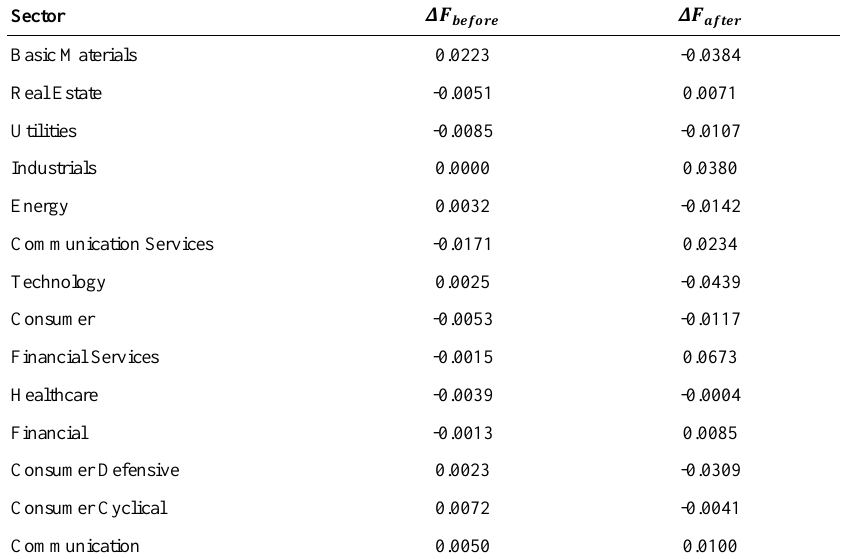
Table 11. The net information outflow for the sectors in S&P ASX market, before and after COVID-19 outbreak